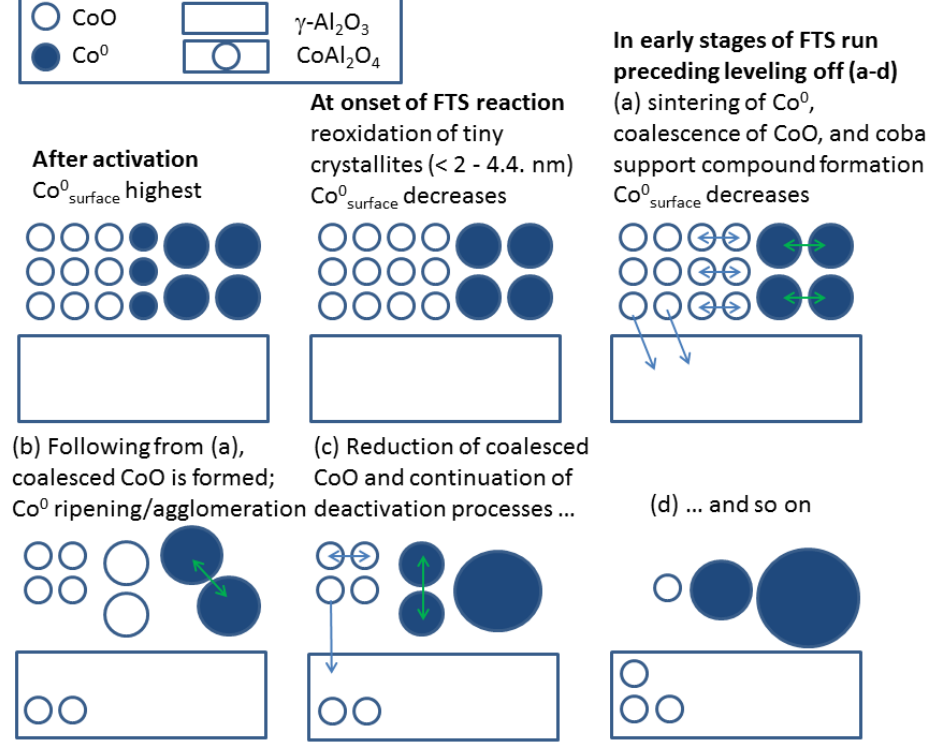
O over 0.5%Pt-15%Co/Al O at T = 210 °C, P = 2.0 2 2 3 h reveals that irreversible deactivation (and a minor cat O addition; ( right ) XANES analysis of the used 2